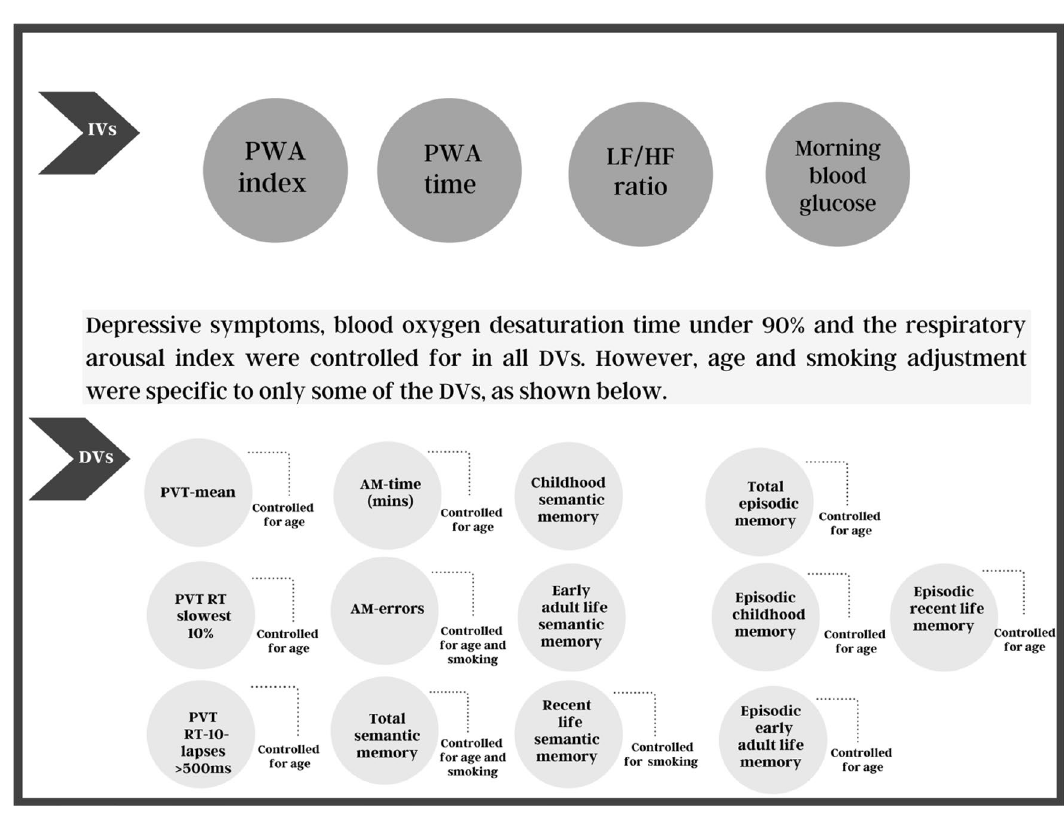
Figure 1. This graph shows the processes of the main analysis for the independent variables, dependent variables and covariates used in the study. PWA pulse wave amplitude, LF low frequency, HF high